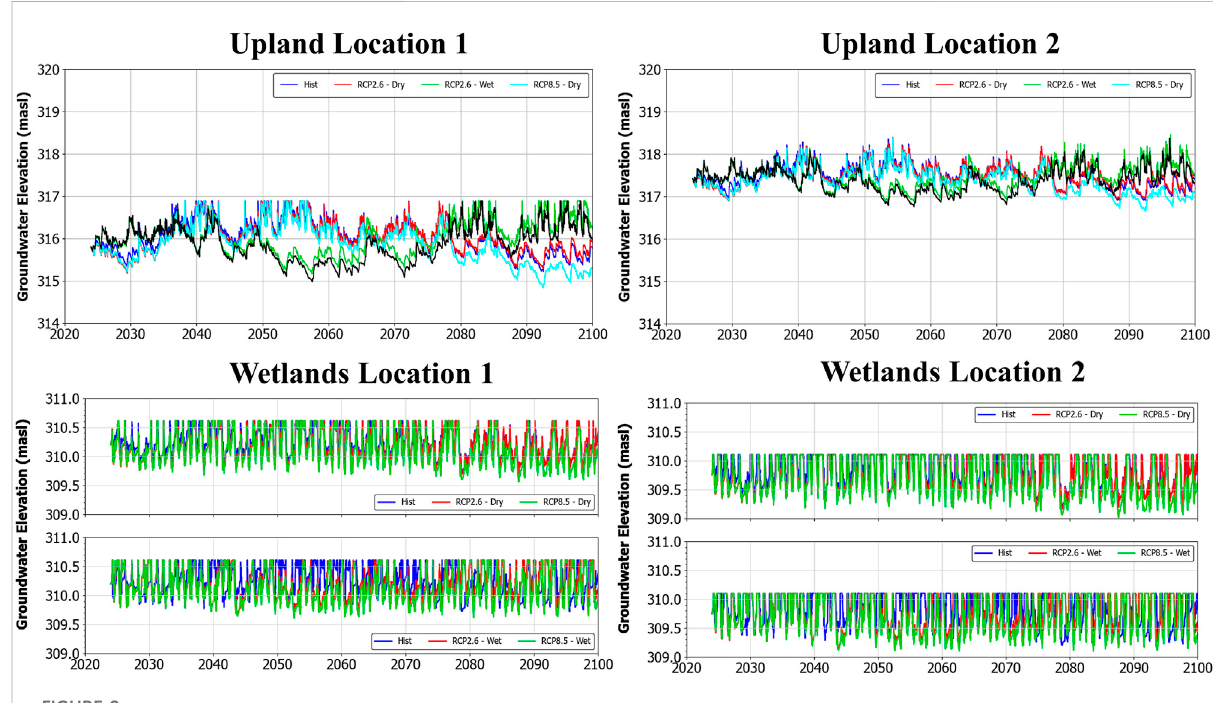
FIGURE 8 Groundwater table elevations in upland and wetlands areas of the reclaimed landform for the different climate scenario